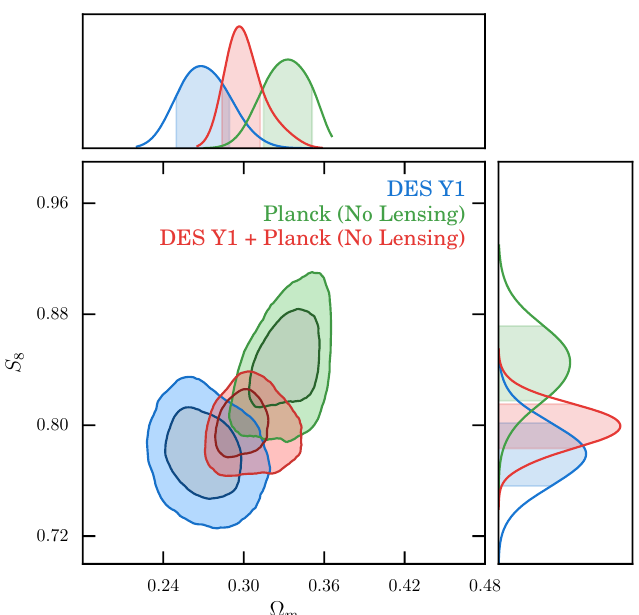
Figure 5. The contours show the 1- and 2- σ constraints for S 8 and Ω m within Λ CDM. The shaded area in the 1-d posteriors shows the 68% confidence region. From Abbott et al. [7].